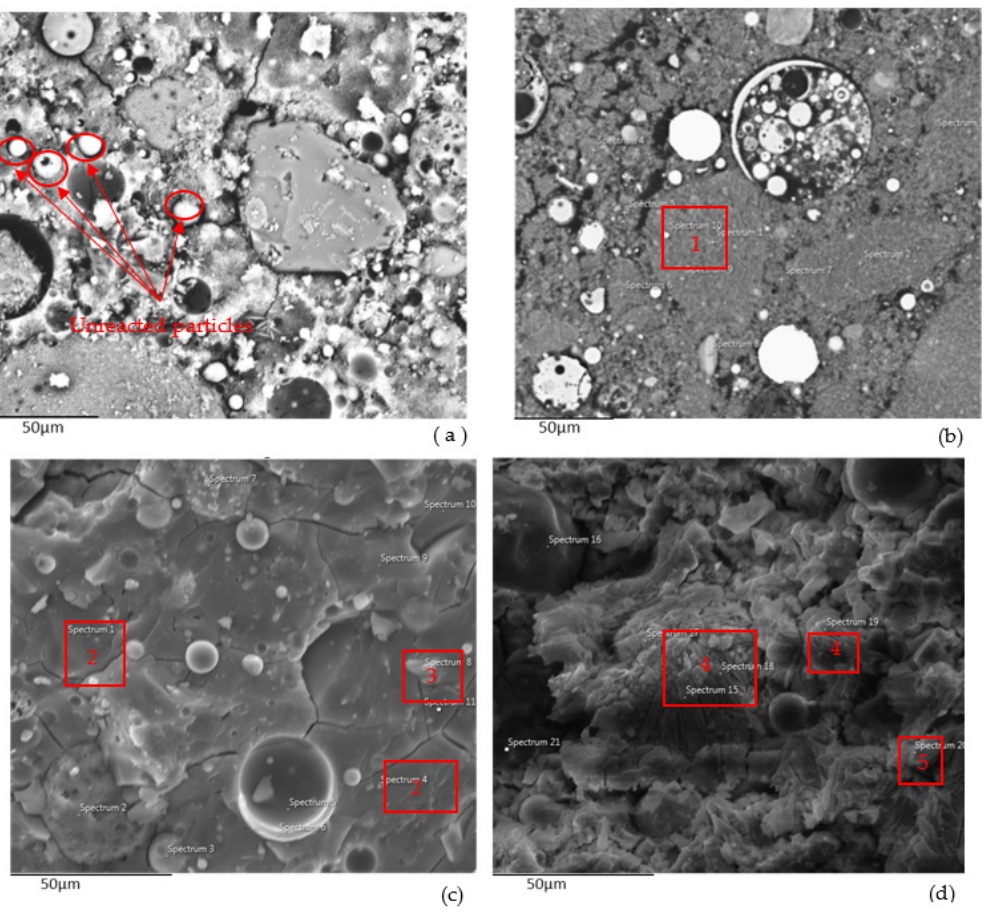
Figure 5. SEM micrographs. ( a ) Neat fly ash activated with commercially available solutions. ( b ) Neat fly ash activated with WG-based sodium silicate. ( c ) 60/40 fly ash/slag blends activated with commercially available solutions. ( d ) 60/40 fly ash/slag blends activated with WG-based sodium silicate.